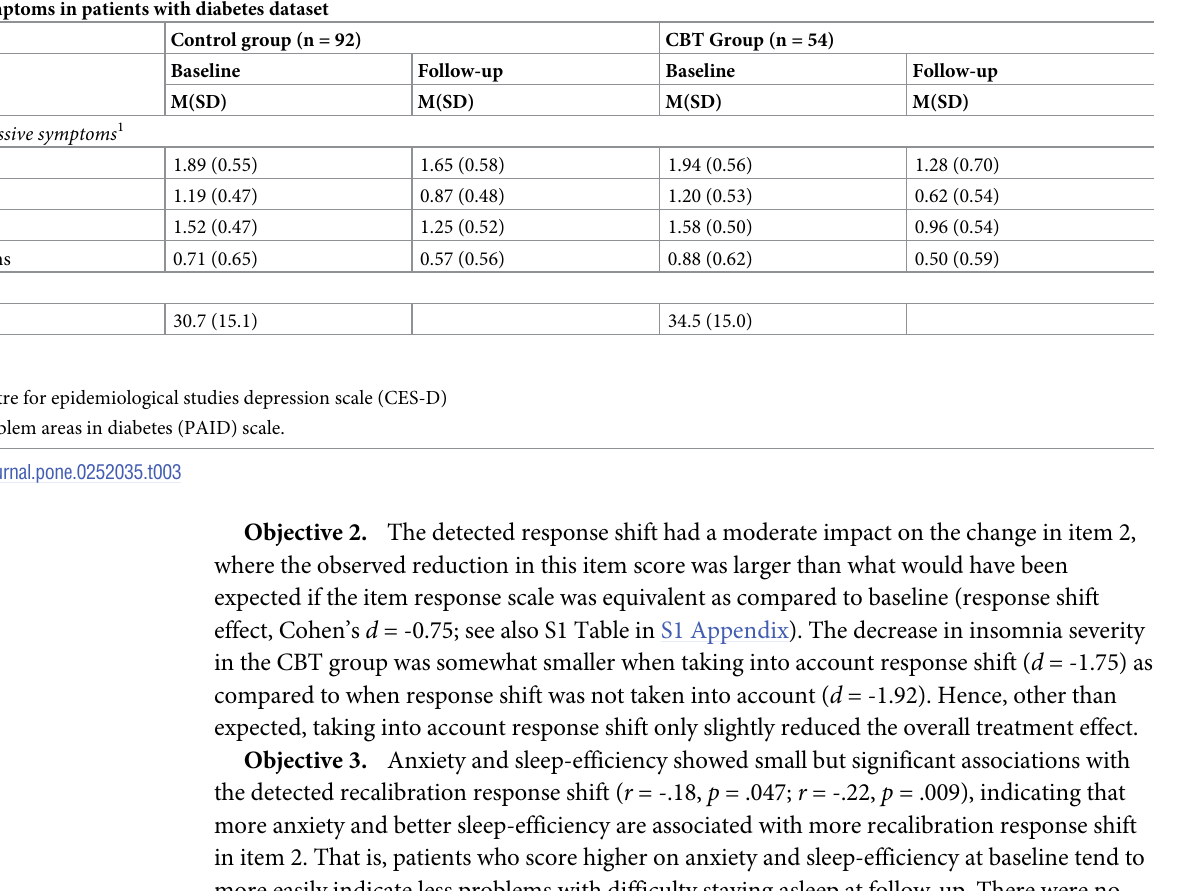
Table 3. Means and standard deviations of the primary outcome and predictor used for response shift analyses of the CBT for depressive symptoms in patients with diabetes dataset. CBT for depressive symptoms in patients with diabetes